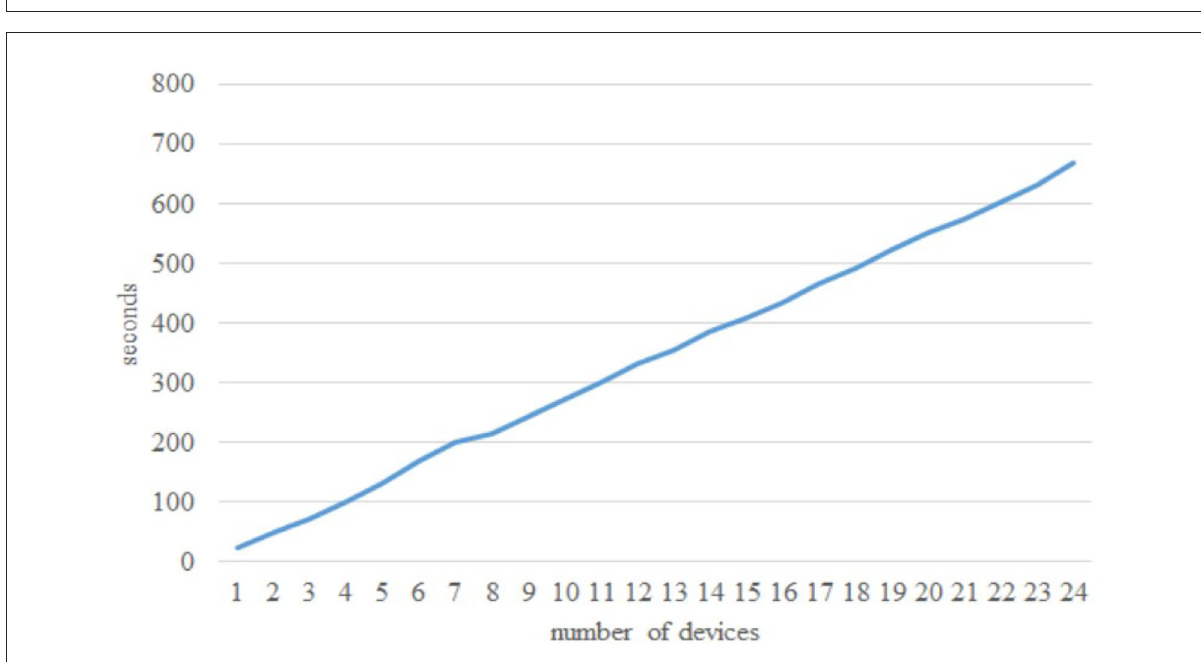
FIGURE6 Federated learning execution